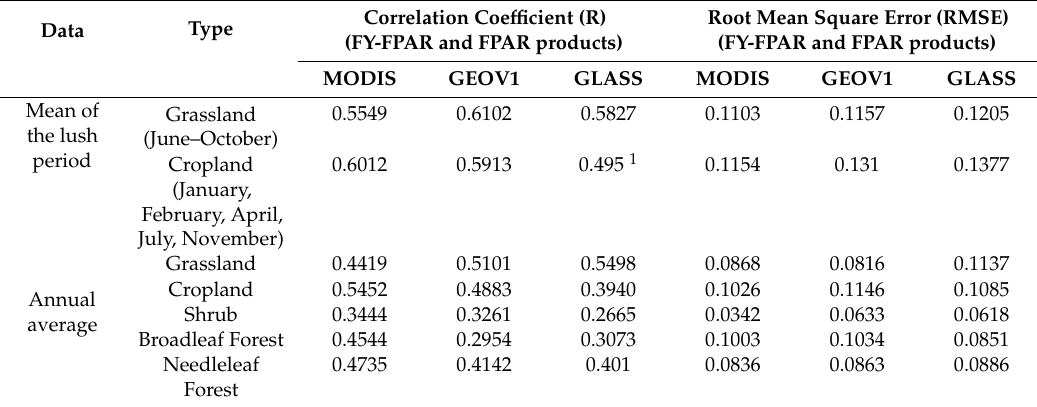
Table 7. Correlation between FY-FPAR and MODIS / GEOV1 / GLASS-FPAR